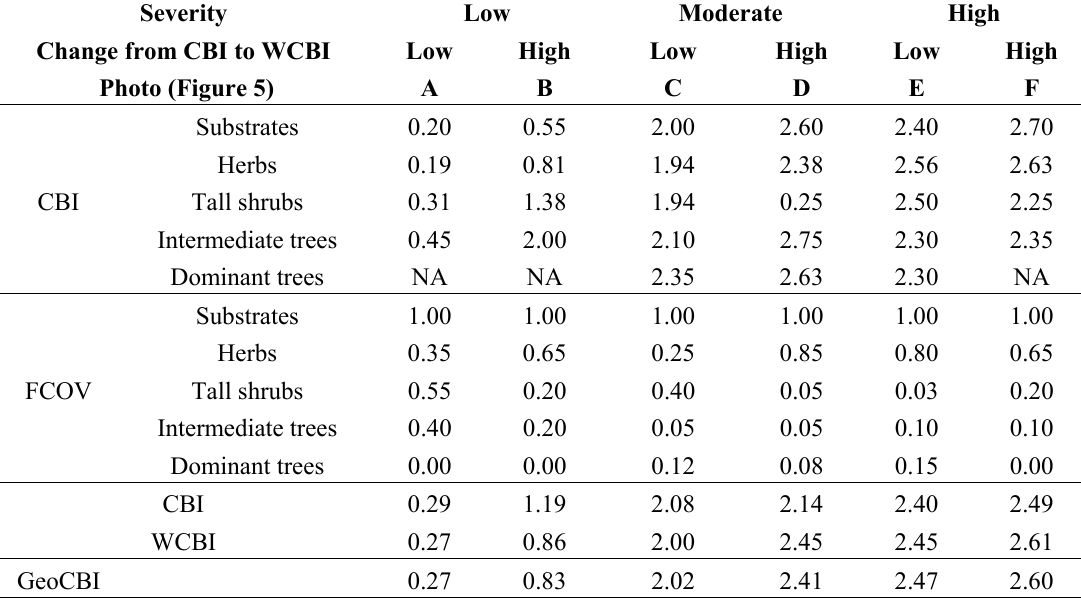
Table 11. Strata CBI scores and FCOV corresponding with plot photos from Figure 5. Plot CBI, WCBI, and GeoCBI are also shown.